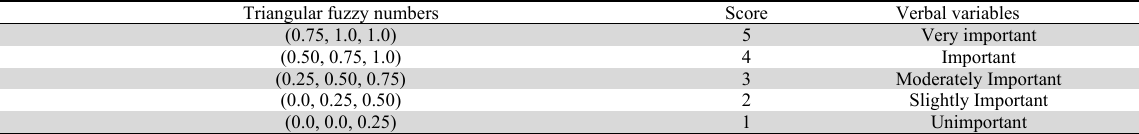
Corresponding values of deterministic and fuzzy